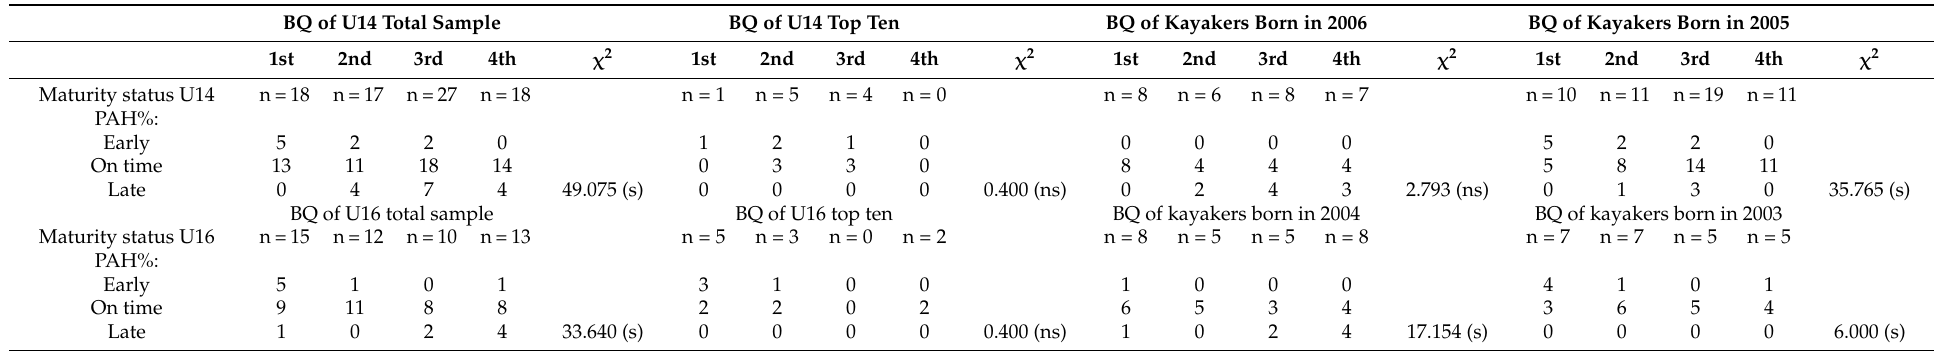
Table 2. Distributions of the kayakers’ maturity status based on PAH% by BQ for the total sample of U14 and 16, top ten U14 and 16, and CYE (U14, 2005; 2006 and U16, 2003; 2004).